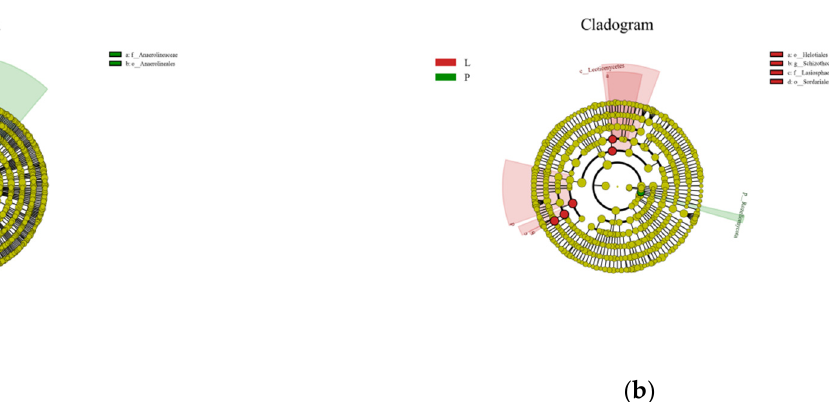
Figure 5. Significance analysis of differences among different treatment groups: L: ridge tillage at two fertilizer depths; P: conventional cultivation; ( a ) bacteria; ( b ) fungi. The circles radiating from inside to outside represent the classification level from phylum to species; each small circle represents a classification at a particular level. The diameter of the small circle is proportional to the relative abundance. Red and green represent ridge tillage at two fertilizer depths (L) and conventional cultivation (P), respectively, and nodes of different colors represent the microbiome that plays an important role in the groups represented by the